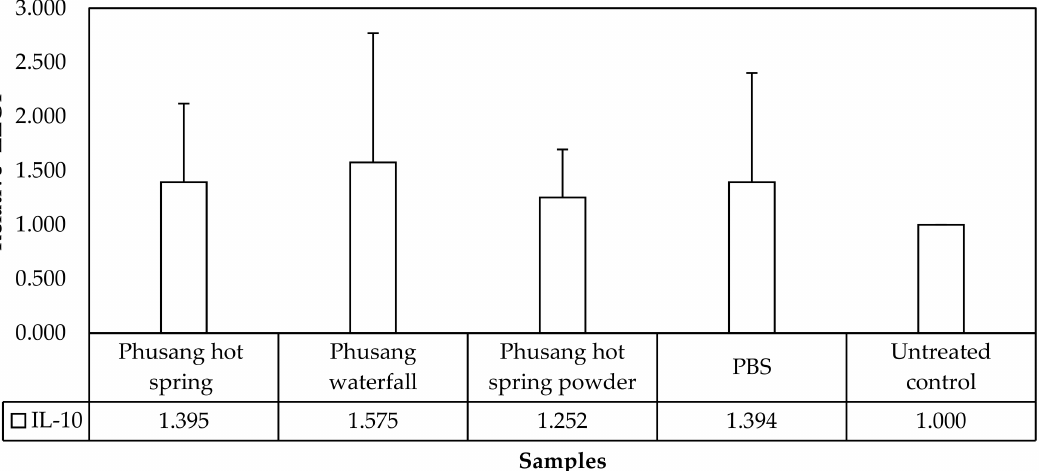
Figure 7. IL-10 expression levels in cultured PBMCs at 24 h, as determined using a semi qRT–PCR